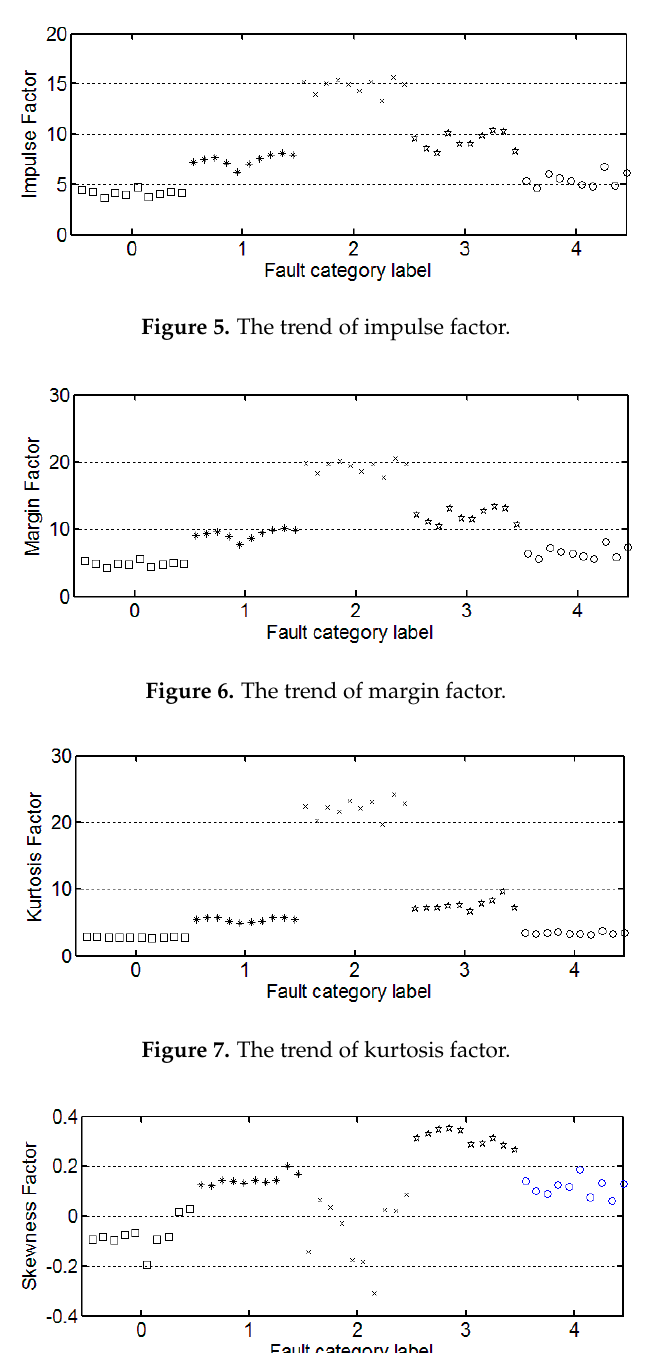
Figure 8. The trend of skewness factor.